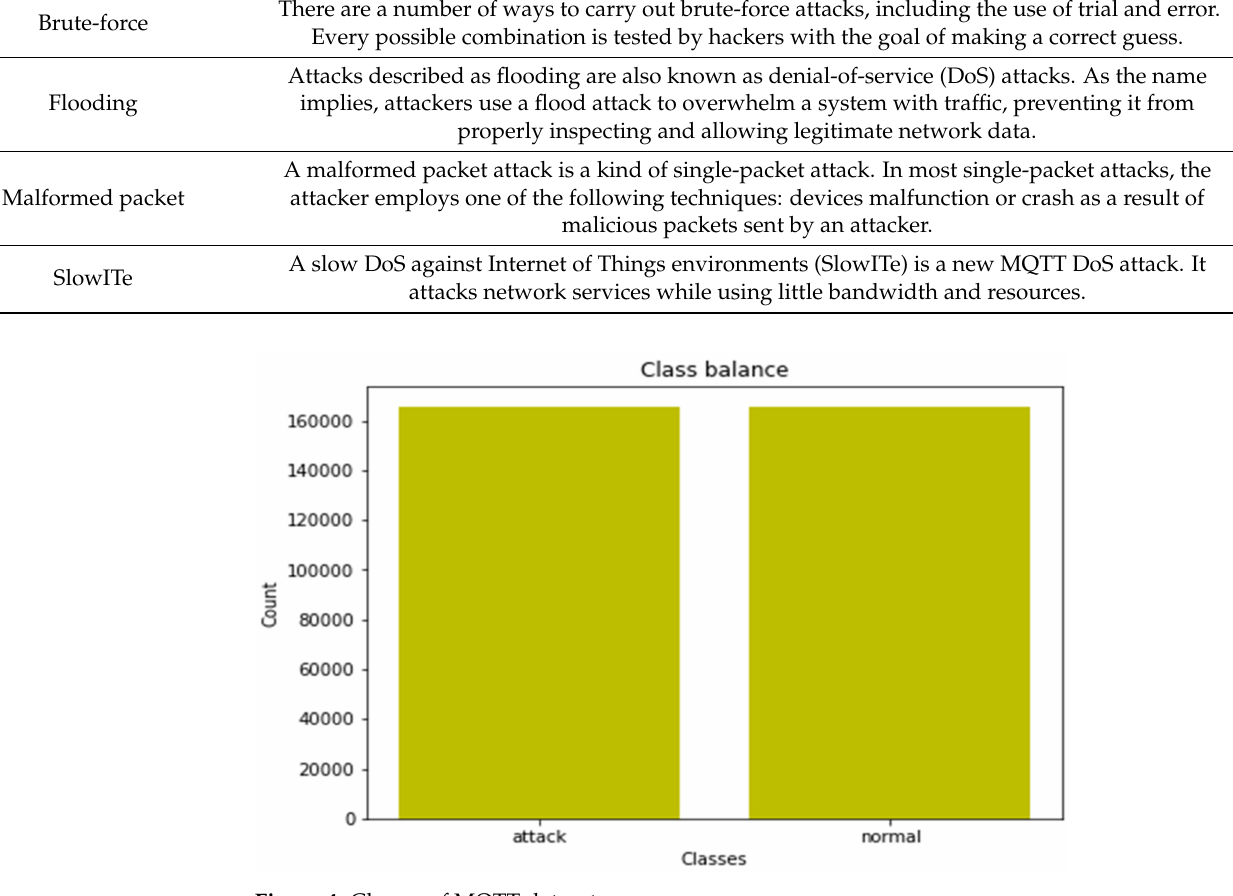
Figure 4. Classes of MQTT